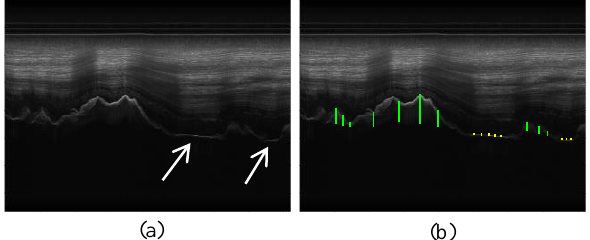
Figure 2 . Example of echogram in AGAP region, it shows the different phenomena of subglacial water and bedrock on the signal thickness and the variance of the signal thickness. (a) the location of two subglacial water (illustrated by white arrows), (b) the different phenomena of subglacial water and bedrock. The green and yellow lines represent the approximate signal thickness of bedrock and subglacial water, respectively. On the whole, the green line is much longer than the yellow line, and the green line is uneven; In contrast, the yellow line is not only very short, but also has no obvious change in the length of a certain subglacial